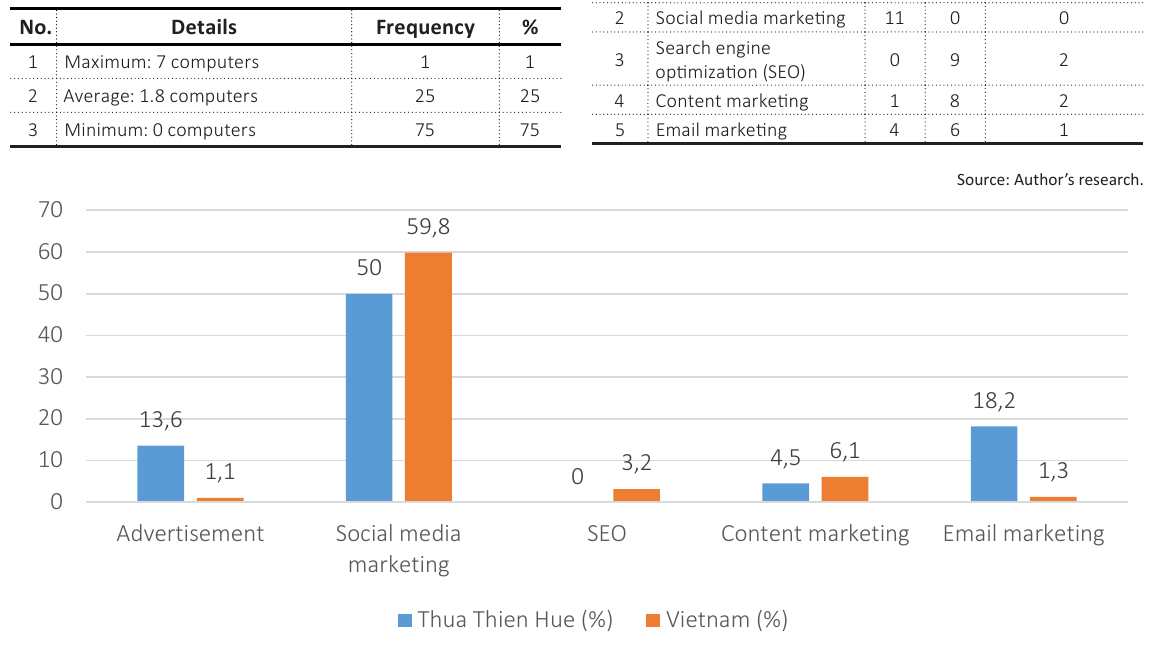
Figure 1. The digital marketing strategies applied in handicraft